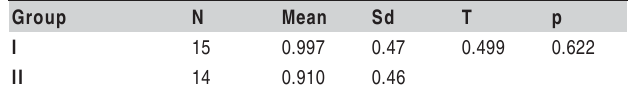
Table 1 - Mean of fluid movements measures and statistical analysis for the groups ( µ /min –1 .10 psi)